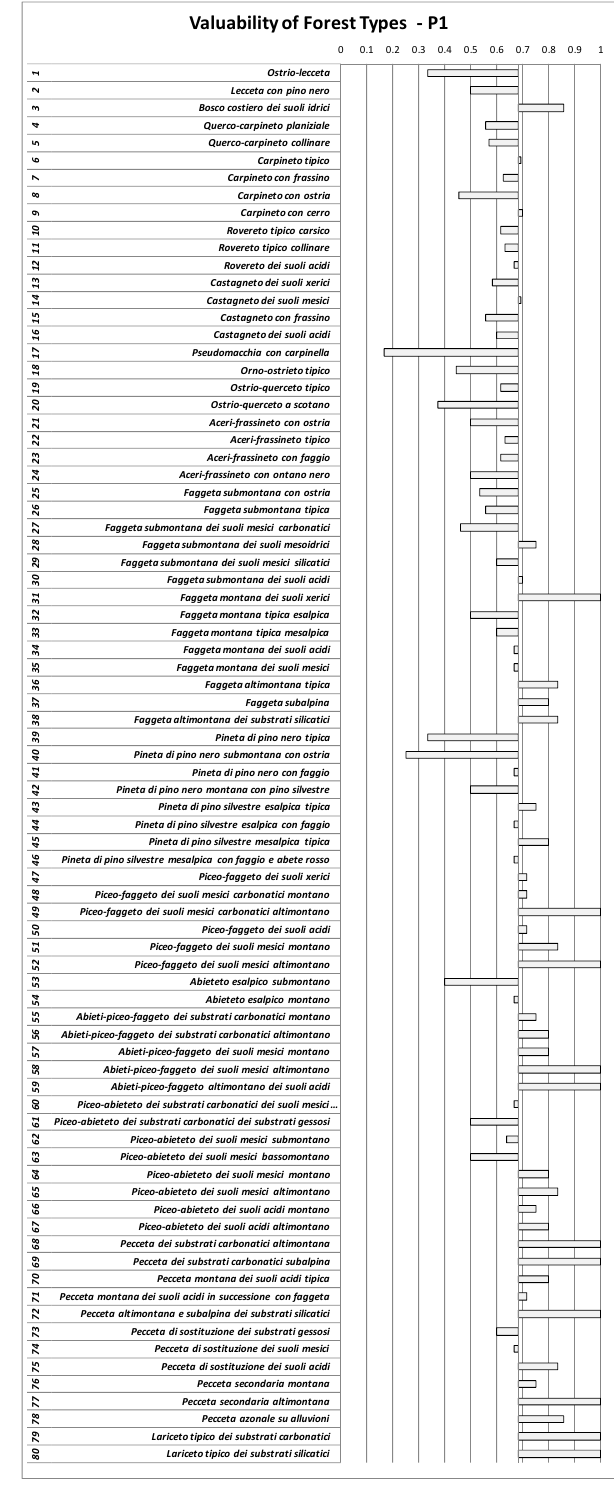
Figure A1. Forest types by increasing altitude. Average P1 value: 0.683963. Below the average = 0; Above the average = 1. Source: authors.